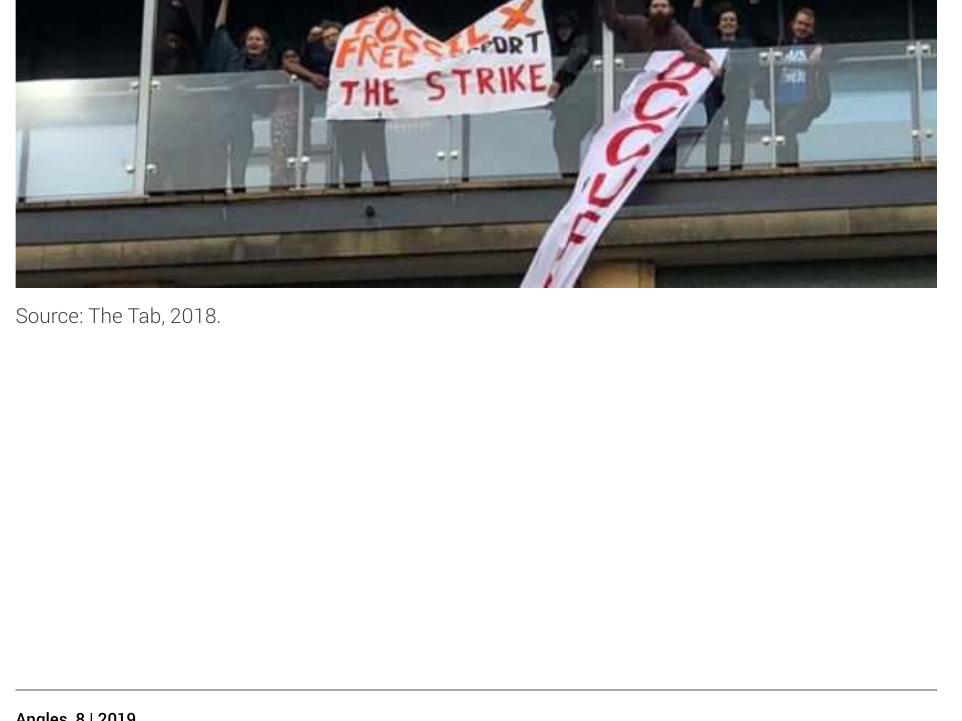
Source: The Tab, 2018.